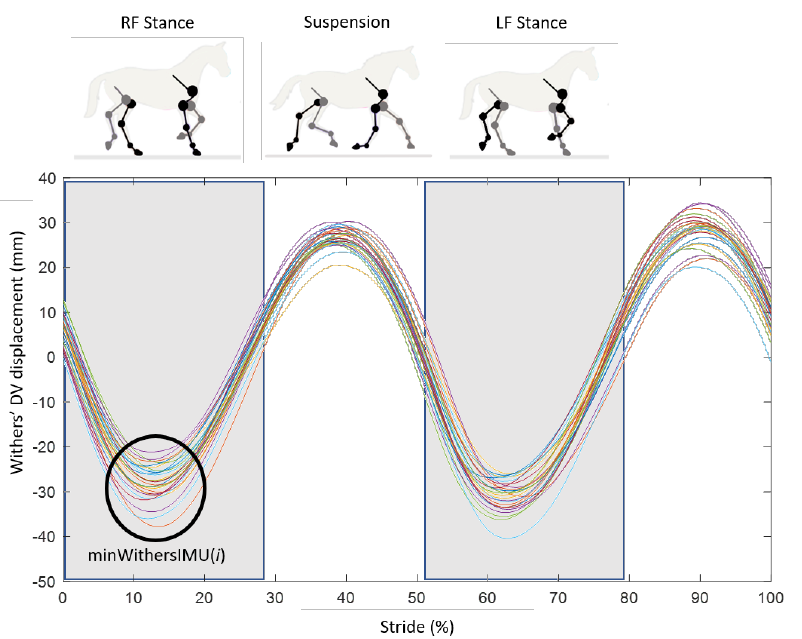
Figure 5. Example of dorso-ventral (DV) displacement curves obtained from the IMU of the withers at a 4 m/s trot (26 standardized strides shown) for one of the eight horses that participated in the experimental protocol. For each stride, the first minimum point is obtained during the first oscillation corresponding with the stance of the right front limb (RF) and named minWithersIMU( i ). It is followed by a suspension phase before reaching a second minimum point during the second oscillation corresponding with the stance of the left front limb (LF).